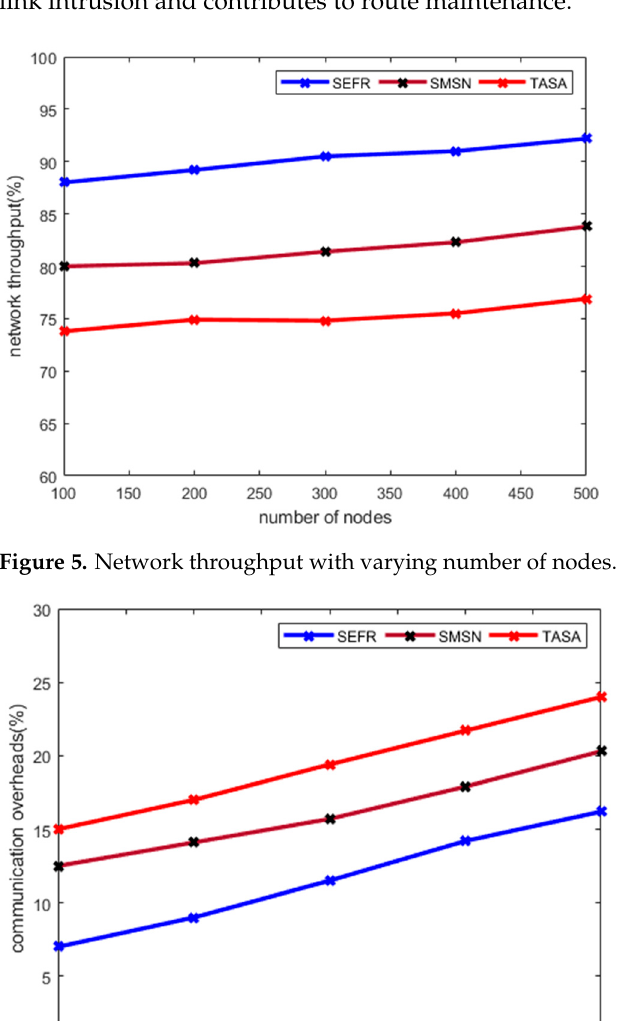
Figure 5. Network throughput with varying number of nodes.